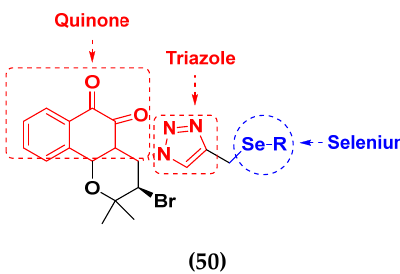
Figure 57. Structure of selenium ‐ based quinone triazole hybrid derivatives ( 50 ).